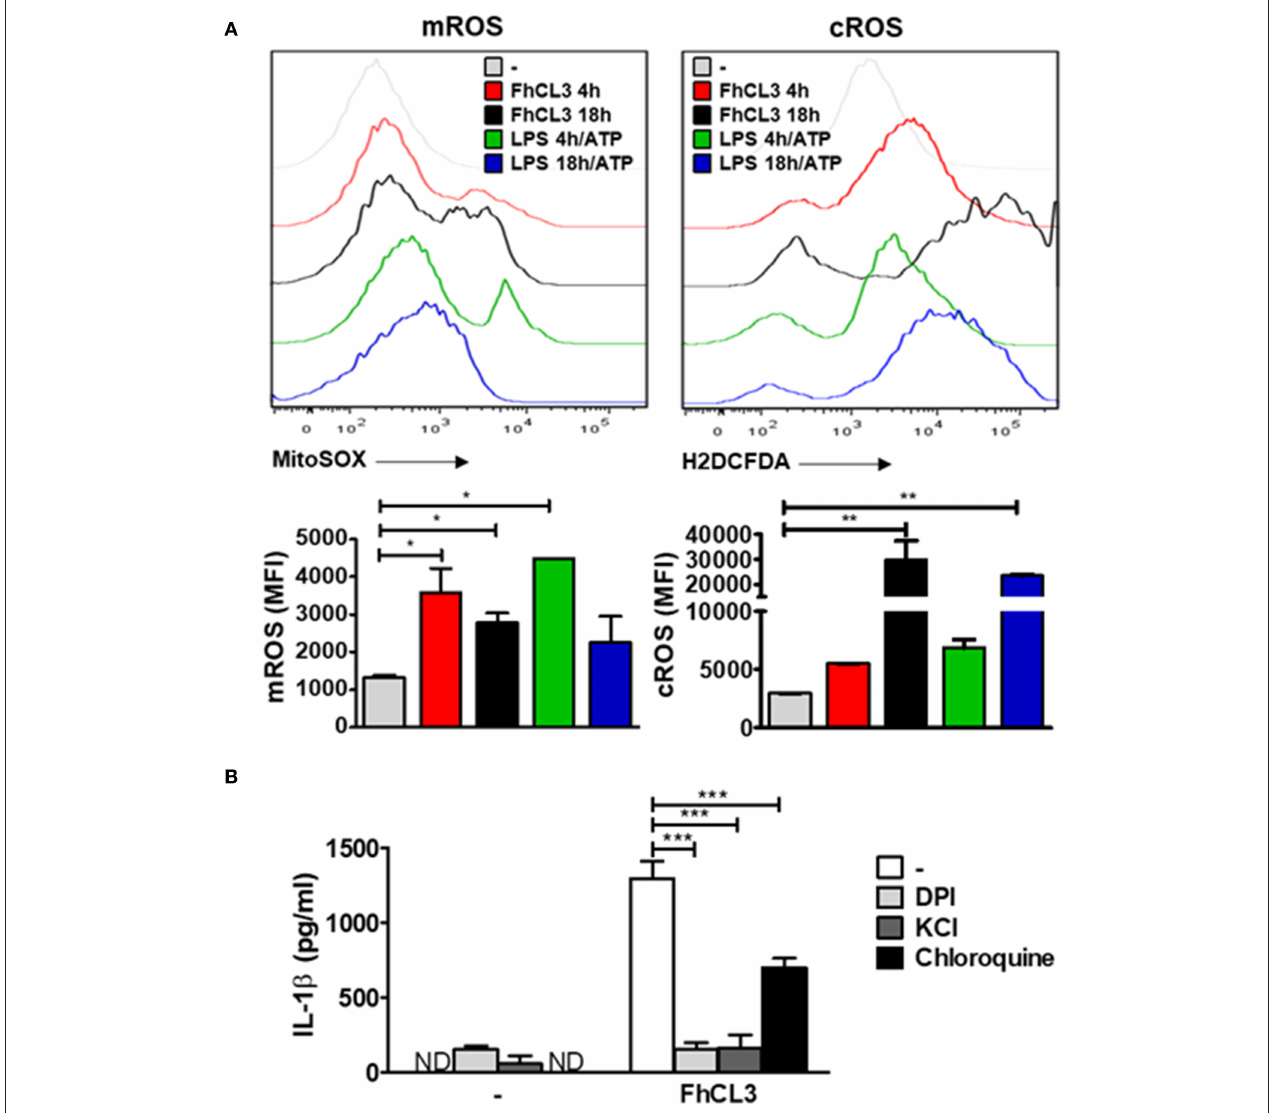
FIGURE 5 | ROS production, potassium (K + ) efflux and lysosomal acidification are involved in FhCL3-induced IL-1 β production in DCs. (A) DCs were stimulated with medium, FhCL3 (10 µ g/mL) or LPS (100ng/mL) plus ATP (5mM) for 4 or 18h. ATP was added the last 30min of culture. Cells were stained with anti-CD11c and anti-MHCII antibodies. Then, DCs were incubated with 5 µ M MitoSOX probe (PE) or 20 µ M H2DCFDA probe for 20min at 37 ◦ C, and analyzed by Flow cytometry. Histograms represent mean fluorescence intensity (MFI) of mROS and cROS on CD11c + MHCII + gated populations with different treatments. Bars depict the mean ± SD and are representative of at least three independent experiments. (B) DCs pretreated or not with DPI (20 µ M, for 3h), KCl (50mM, for 90min) or choloroquine (5mM for 1h), were stimulated with FhCL3 (10 µ g/mL) for 18h. Then IL-1 β secretion was quantified by ELISA in supernatants. Experiments were repeated three times with similar results being obtained and are expressed as in bars graph mean ± SD ND, not detected; * p < 0.05; ** p < 0.01; *** p < 0.001 (ANOVA